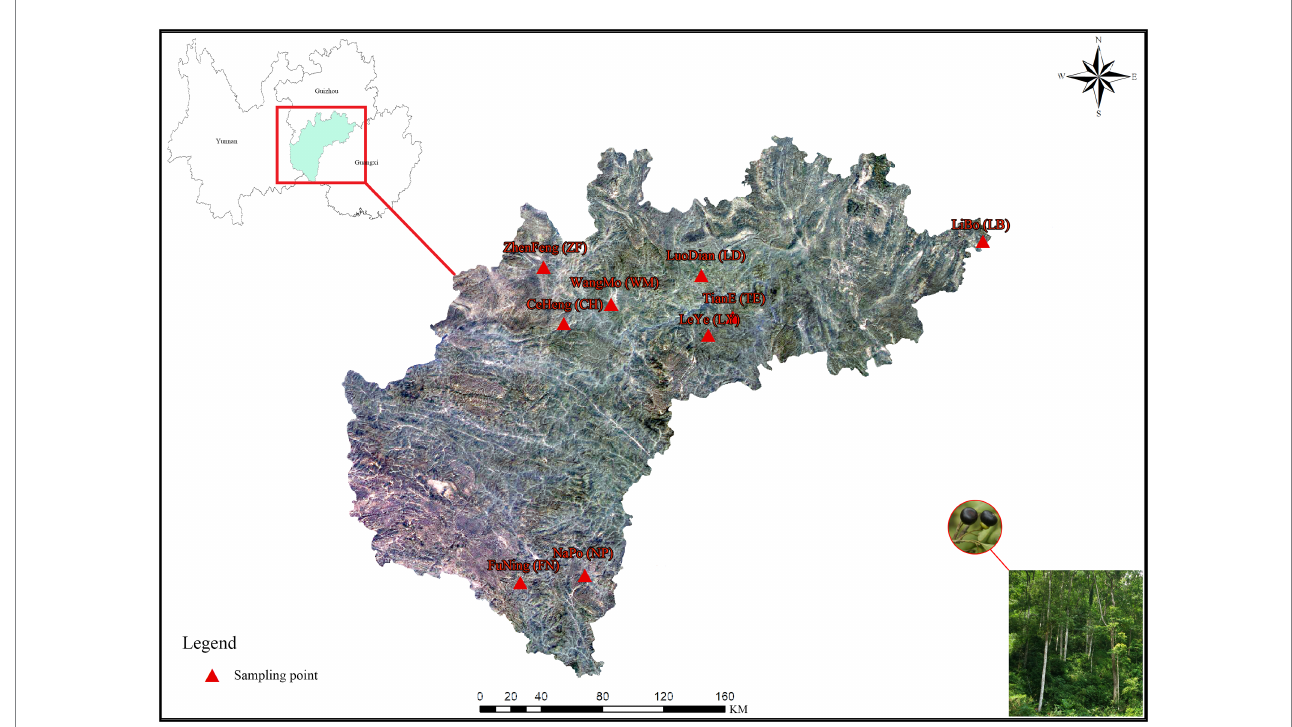
FIGURE 1 Map of the Cinnamomum migao sample collection sites. The map comes from the standard map service system of the Ministry of natural resources, PRC (http://bzdt.ch.mnr.gov.cn/), which is authorized for free. The picture in the right corner was taken by the first author during field investigation. The nine C. migao sampling points at the junction of Guizhou Province, Guangxi Province, and Yunnan Province, China.